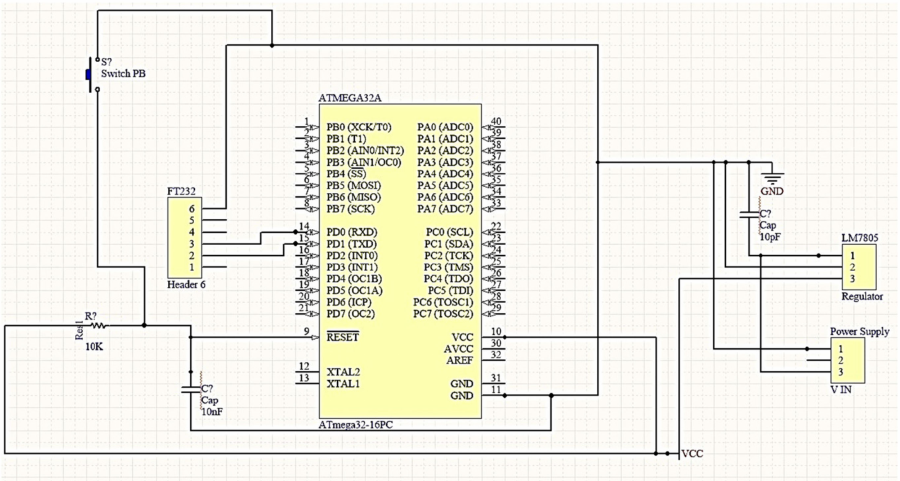
Figure 10. Designed board